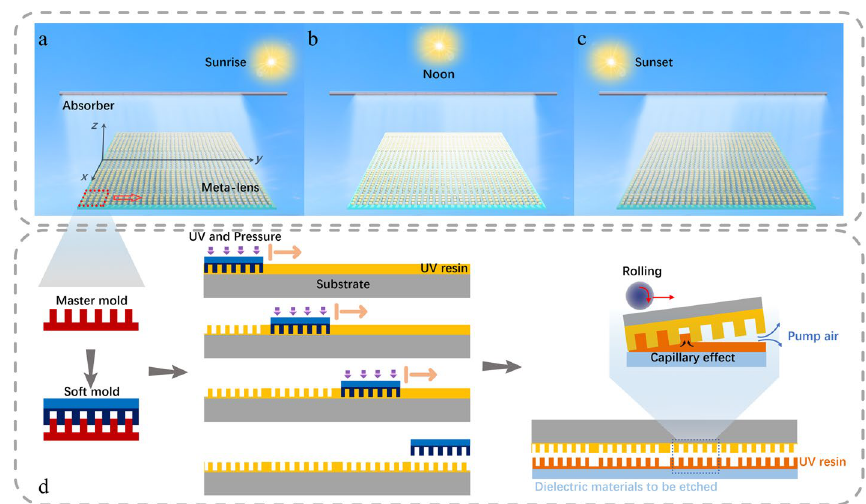
Fig. 14 a-c Linear-focusing meta-lens and its focal performance vary from sunset to sunrise. d Fabrication process for the large-scale meta-lens using NIL